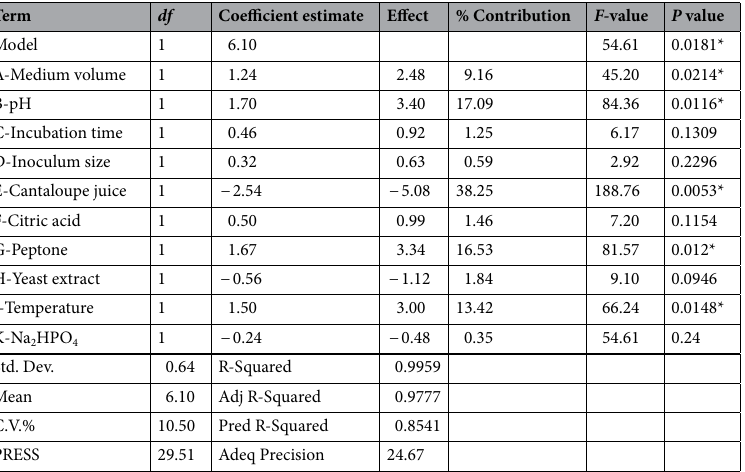
Table 3. Statistical analysis of Plackett–Burman design showing coefficient estimate, effect, % contribution, F -value and P value for each factor affecting bacterial nanocellulose production by Bacillus sp . strain SEE-3.